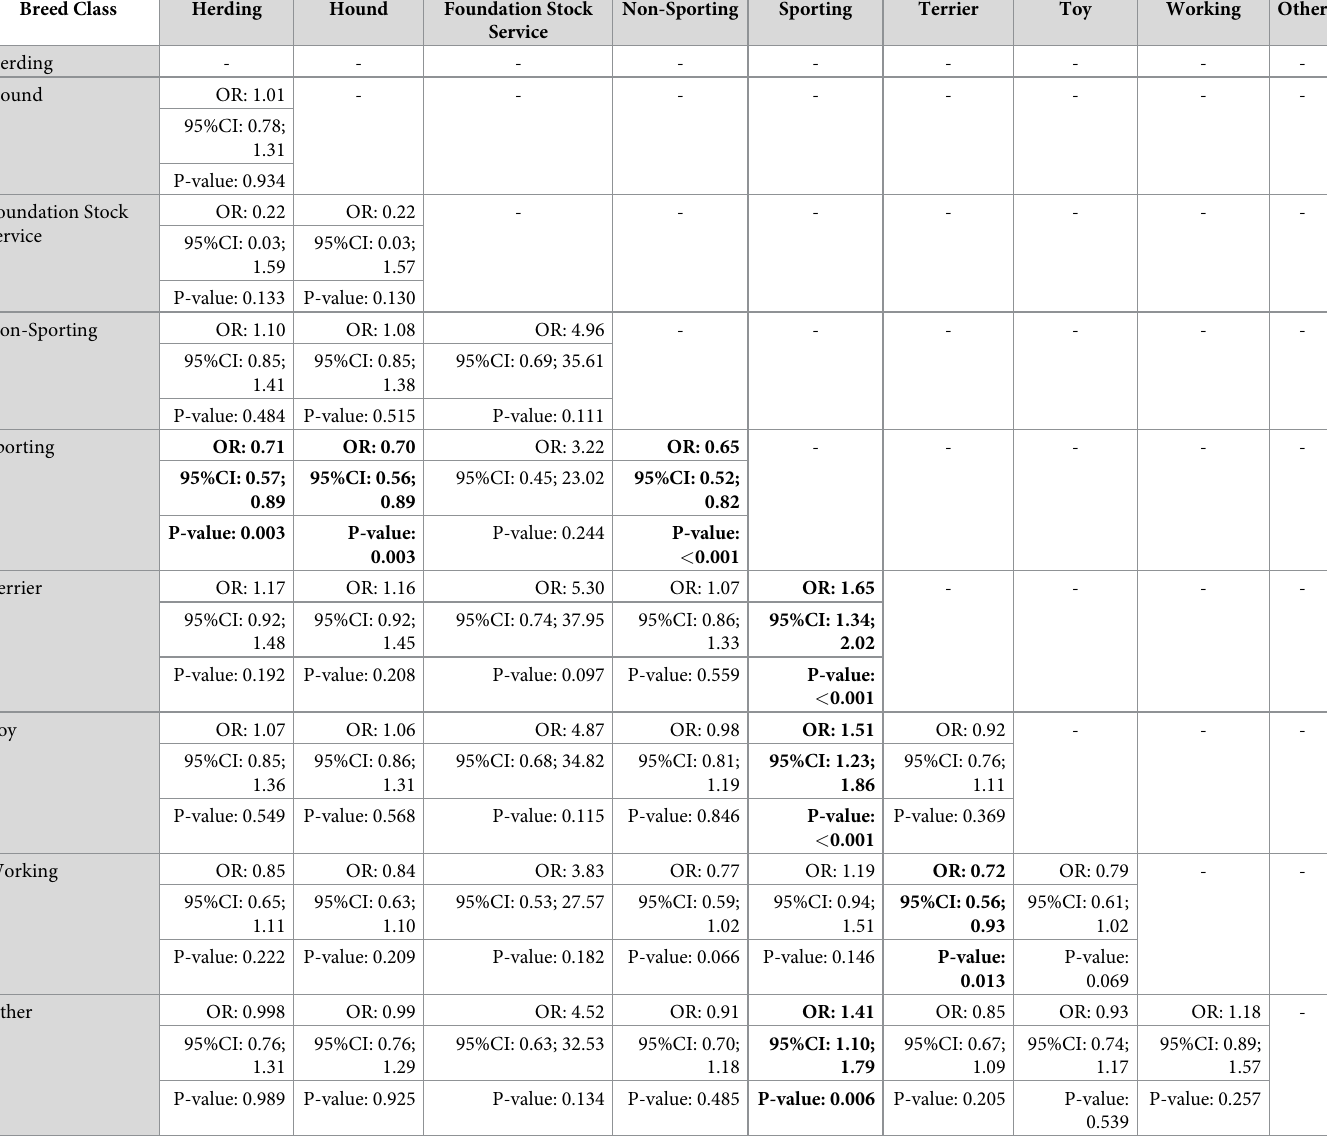
Table 8. Table of contrasts � examining the associations between each breed class on the odds of a poisoning call to the APCC a being related to cannabis (2009– 2014). Breed Class Herding